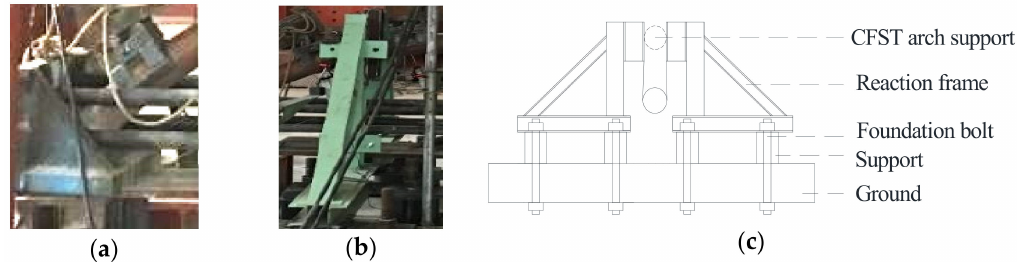
Figure 4. Restraint devices: ( a ) the restraint devices of the end; ( b ) the actual lateral devices; ( c ) the structure of the lateral